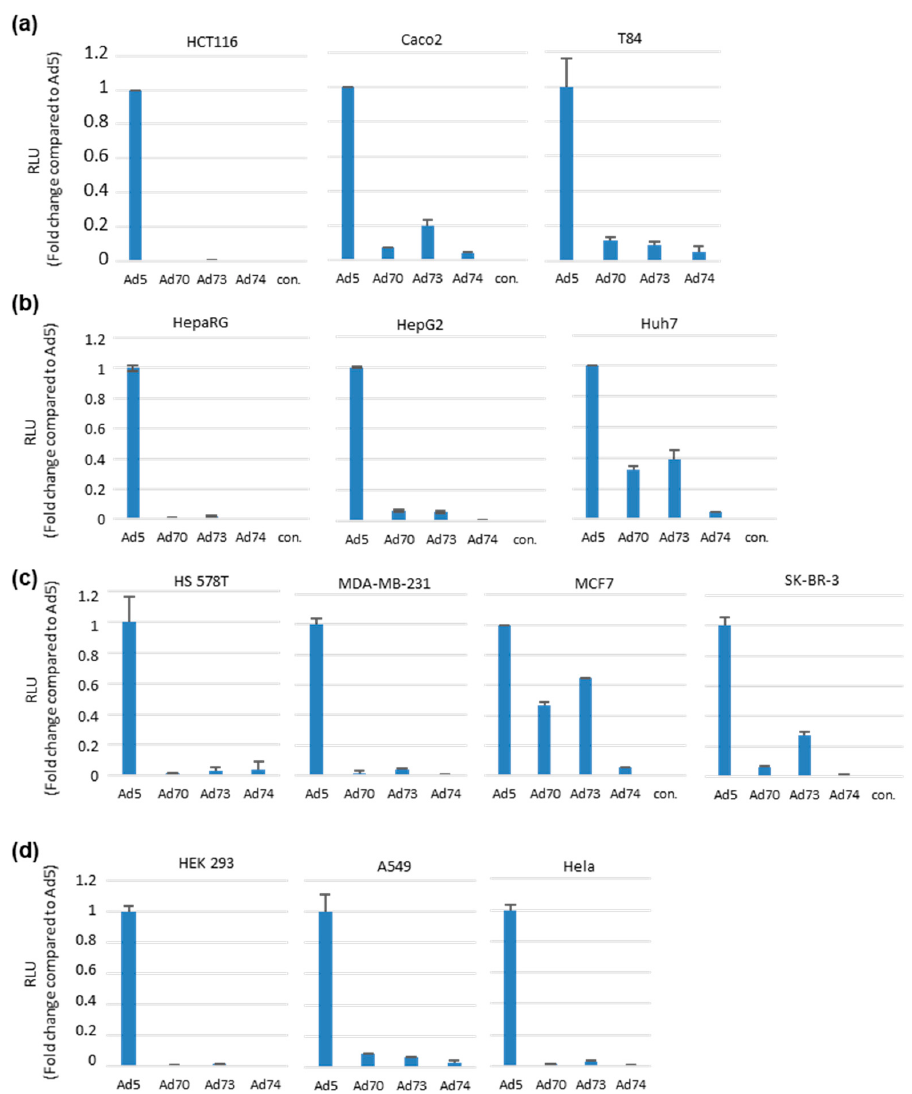
Figure 5. Screening of the reporter-tagged new species D human adenoviruses (HAdV-D) in human tumor cells. Transgene expression efficiency of different adenovirus types (Ad type number) was tested in a panel of disease-specific cell lines. Shown are ( a ) colon carcinoma derived cell lines, ( b ) hepatocellular carcinoma derived cell lines, ( c ) breast cancer derived cell lines, and ( d ) typical adenovirus propagation cell lines. Cells were infected at 100 viral particles per cell, luciferase expression was measured 24 h post infection by addition of furimazine substrate and expressed as relative light units (RLU). Levels were compared to the commonly used adenovirus type 5 (Ad5) and indicated as fold change. In all cell lines, error bars represent mean ± SD ( n = 3).